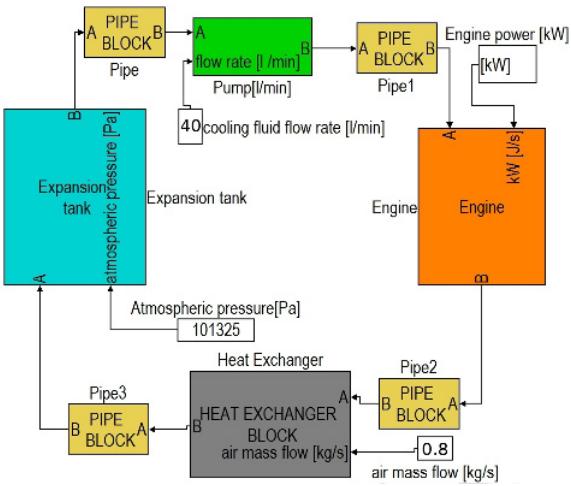
Fig. 5. Designed cooling circuit for simulation.